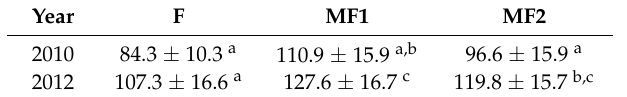
Table 1. Total soil carbon stock (Mg C ha − 1 ) in the F, MF1 and MF2 plots in 2010 and 2012 (experiment 1).